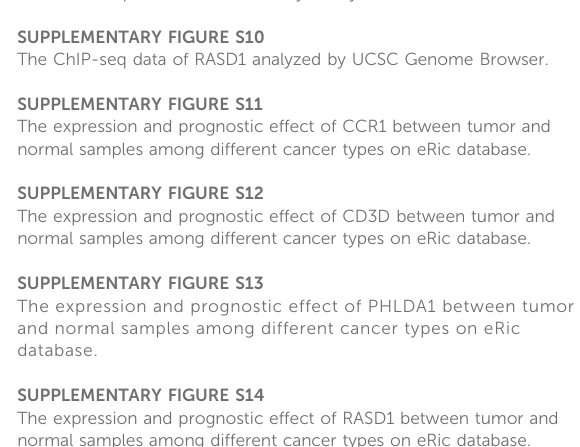
SUPPLEMENTARY FIGURE S3 Humanproteinatlasdatabase.ThemediumexpressionofCD3D (A) ,MAZ (B) , and PHLDA1 (C) in normal tissue by immunohistochemical staining assay. SUPPLEMENTARY FIGURE S4 Oncomine database. The expression of CCR1 (A) , CD3D (B) , MAZ (C) , PHLDA1 (D) , and RASD1 (E) in tumor and normal tissues at the pan- cancer level. SUPPLEMENTARY FIGURE S5 CCLE database. The expression of CCR1 (A) , CD3D (B) , MAZ (C) , PHLDA1 (D) , and RASD1 (E) in various different tissues. SUPPLEMENTARY FIGURE S6 cBioPortal database and GEPIA database. The correlation of mutation count of CCR1 (A), CD3D (B), RASD1 (C) , PHLDA1 (D) , and MAZ (E) and overall survival. (F) The summary of patients ’ clinical information and genetic alteration of DEeRNAs. (G) The survival analysis of PHLDA1. SUPPLEMENTARY FIGURE S7 The ChIP-seq data of CCR1 analyzed by UCSC Genome Browser. SUPPLEMENTARY FIGURE S8 The ChIP-seq data of CD3D analyzed by UCSC Genome Browser. SUPPLEMENTARY FIGURE S9 The ChIP-seq data of PHLDA1 analyzed by UCSC Genome Browser. SUPPLEMENTARY FIGURE S10 The ChIP-seq data of RASD1 analyzed by UCSC Genome Browser. SUPPLEMENTARY FIGURE S11 The expression and prognostic effect of CCR1 between tumor and normal samples among different cancer types on eRic database. SUPPLEMENTARY FIGURE S12 The expression and prognostic effect of CD3D between tumor and normal samples among different cancer types on eRic database. SUPPLEMENTARY FIGURE S13 The expression and prognostic effect of PHLDA1 between tumor and normal samples among different cancer types on eRic database. SUPPLEMENTARY FIGURE S14 The expression and prognostic effect of RASD1 between tumor and normal samples among different cancer types on eRic